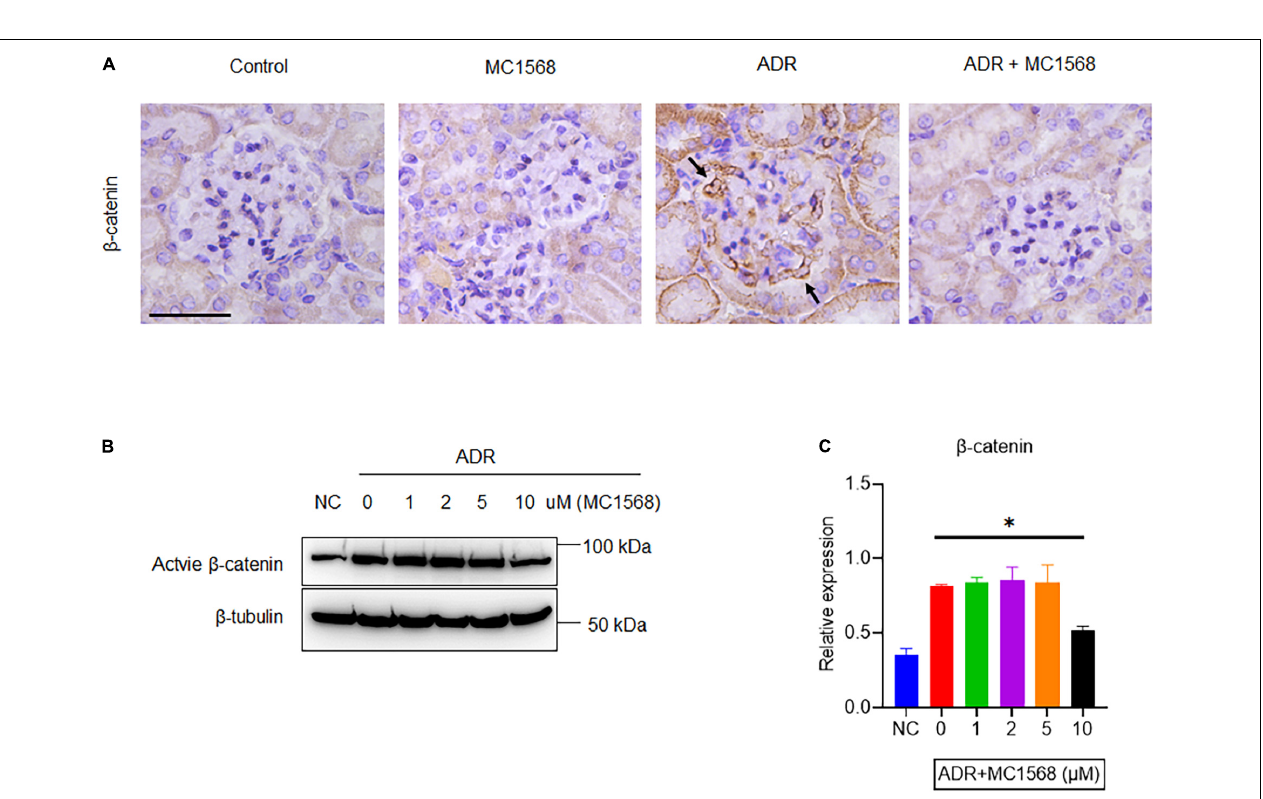
FIGURE 8 | MC1568 suppresses ADR-induced β -catenin activation. (A) Representative images of IHC staining of β -catenin expression (arrows) in control and ADR-injected mice treated with or without MC1568. (B,C) Immunoblotting and quantification analysis of active β -catenin expression in ADR-stimulated podocytes with or without MC1568 treatment. Statistical analysis was performed with two-way ANOVA. ∗ p < 0.05. Scale bar, 40 µ m.